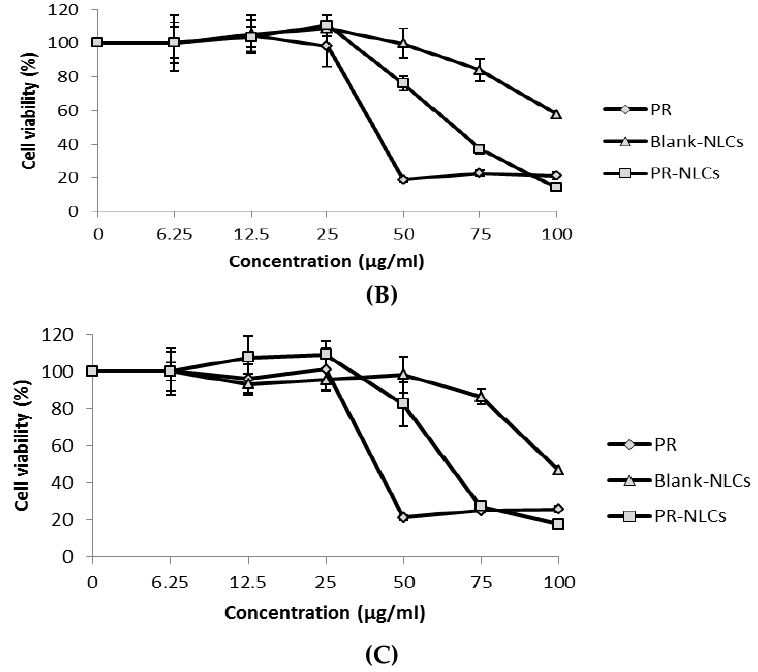
Figure 9. In vitro cytotoxicity of PR solution, blank-NLCs, and PR-NLCs in HaCaT cells for ( A ) 24 h; ( B ) 48 h; ( C ) 72 h ( n = 3, mean ± SD).